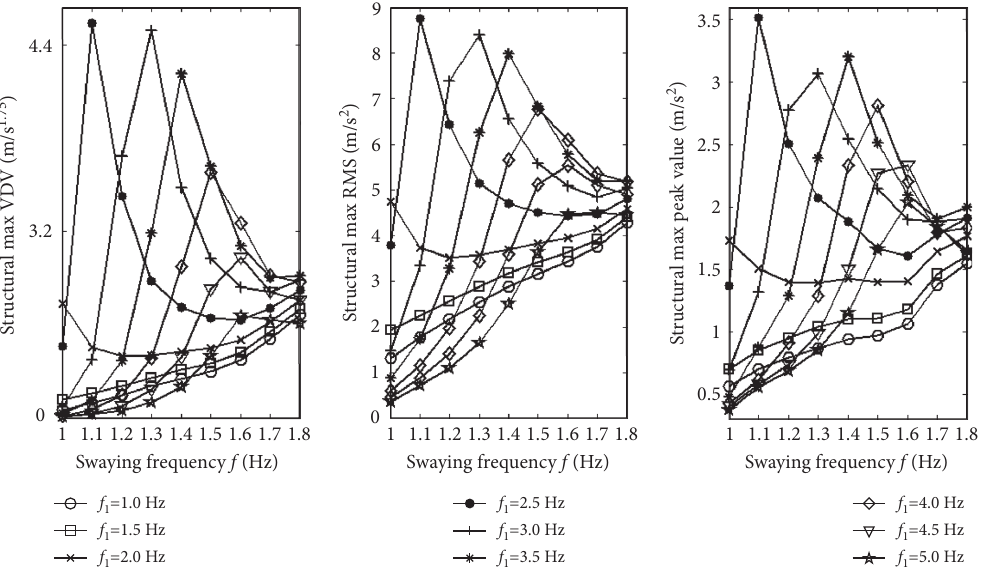
Figure 25: The max VDV, RMS, and peak values plotted against swaying